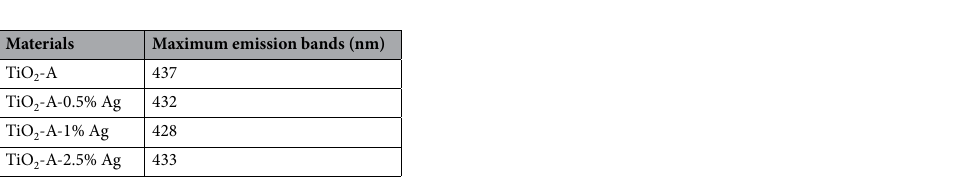
Table 6. Maximum emission bands of pristine TiO 2 -A and modified with Ag NPs.